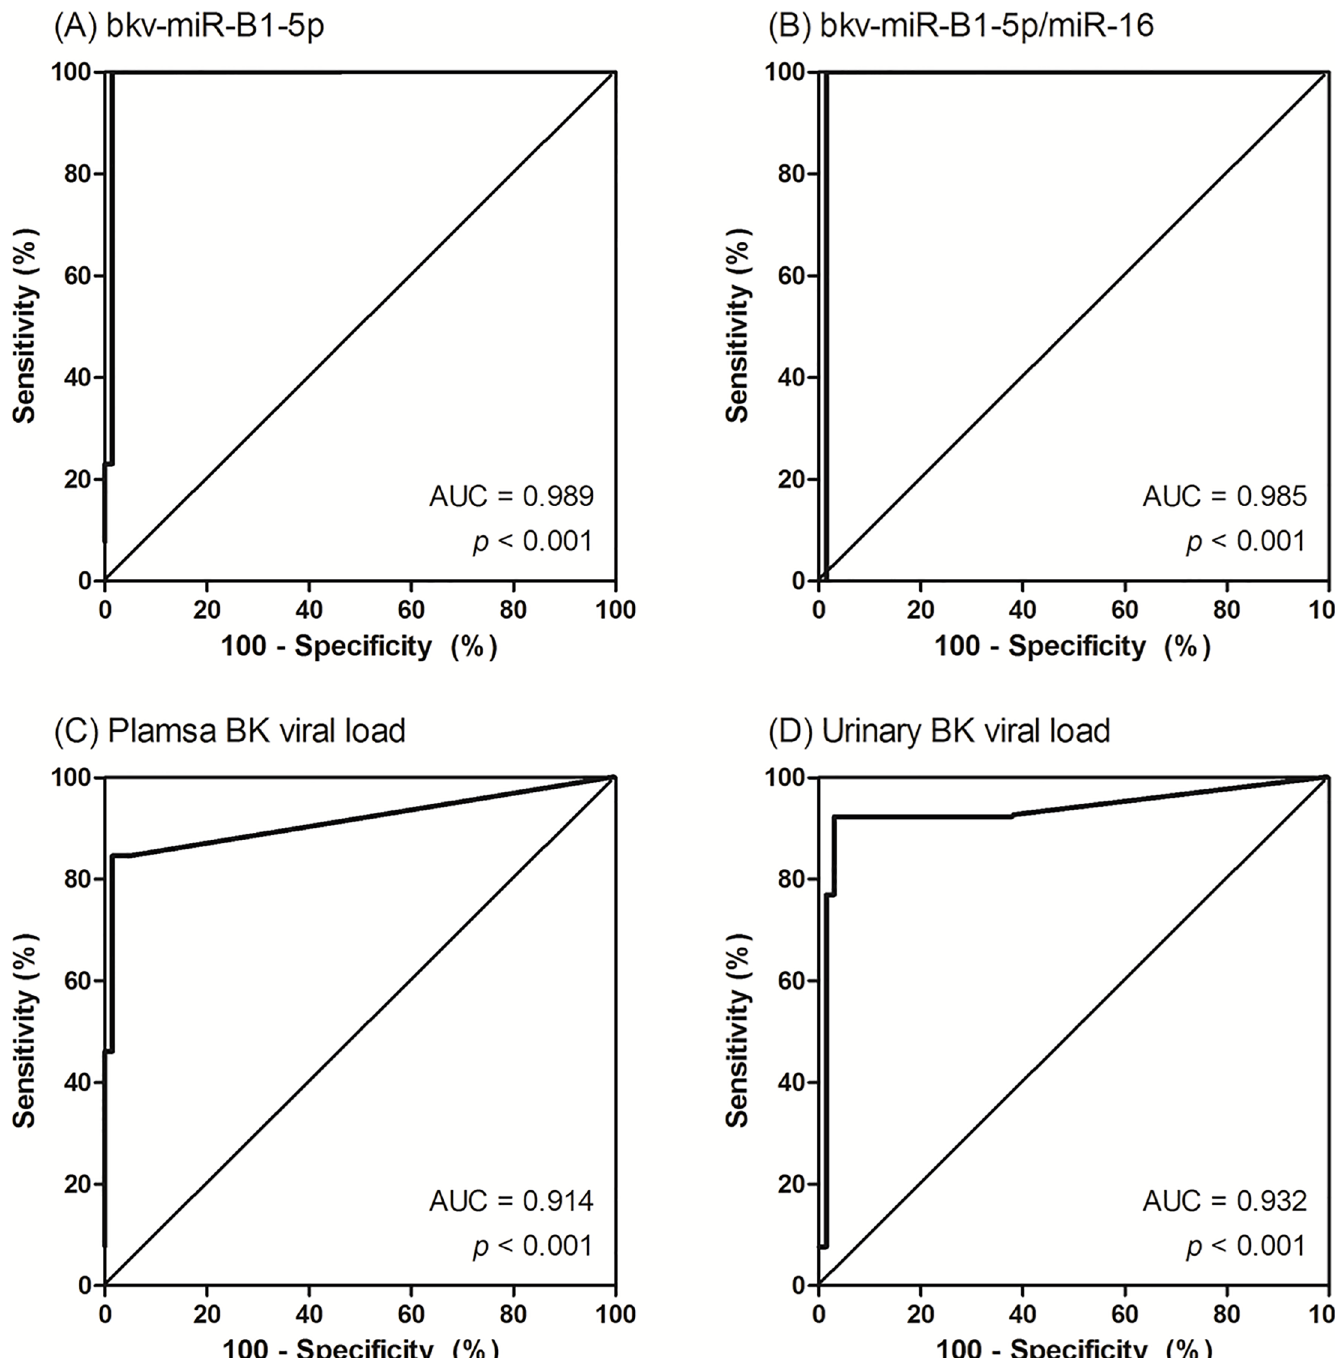
Fig 4. Receiveroperating characteristic (ROC) curves for the diagnosis of BK virus nephropathy (BKVN) using (A) bkv-miR-B1-5p, (B) bkv- miR-B1-5p/miR-16, (C) plasma BK viral load, and (D) urinary BK viral load. ROC curves demonstrating diagnostic accuracy for detectingpatients with BKVN by area under the curve (AUC). The AUC for bkv-miR-B1-5p, bkv-miR-B1-5p/miR-16,plasma BK viral load, and urinary BK viral load are 0.989, 0.985, 0.914, and 0.932, respectively.